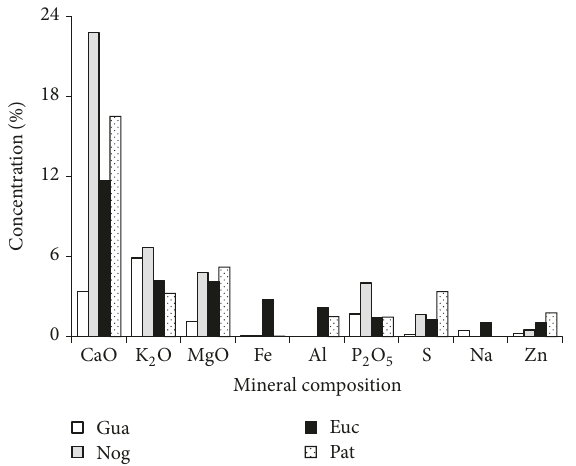
Figure 3: Ash chemical composition of firewood.